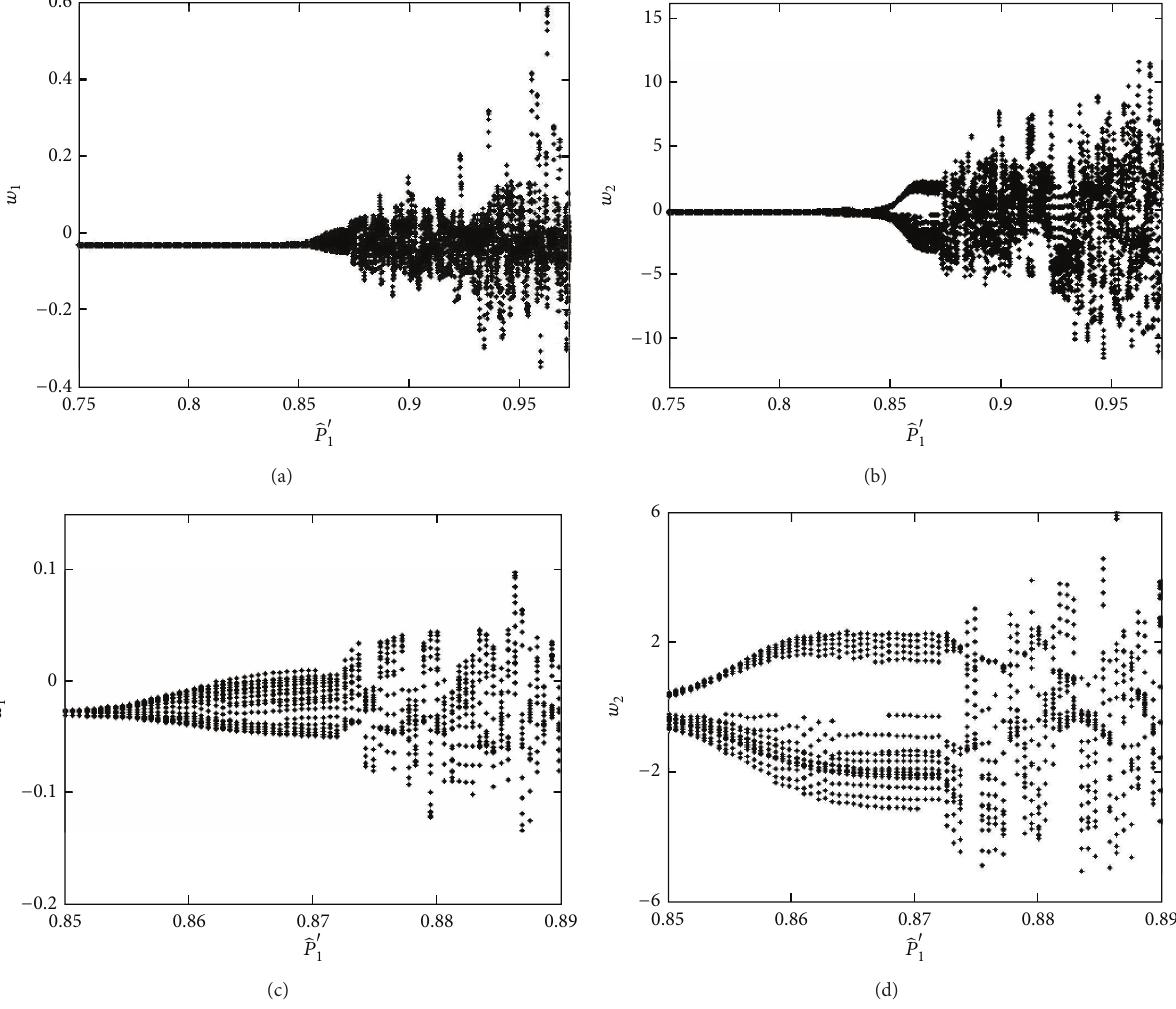
Figure 3: (a) and (b) depict the bifurcation diagrams of 𝑃 󸀠 1 versus the first two modes 𝑤 1 and 𝑤 2 which are given when the volume fraction index is taken to be 0.5. The Mach number is taken to be 5.0. The magnitude and frequency of the in-plane excitation are taken to be 𝑃 󸀠 1 ∈ [5.5 × 10 7 , 7.79 × 10 7 ] and 161Hz, respectively. (c) and (d) are partially enlarged details for (a) and (b), respectively. The value of horizontal ̂ 𝑃 󸀠 = 𝑃 󸀠 /7.79 × 10 7 coordinate is defined as 1 1